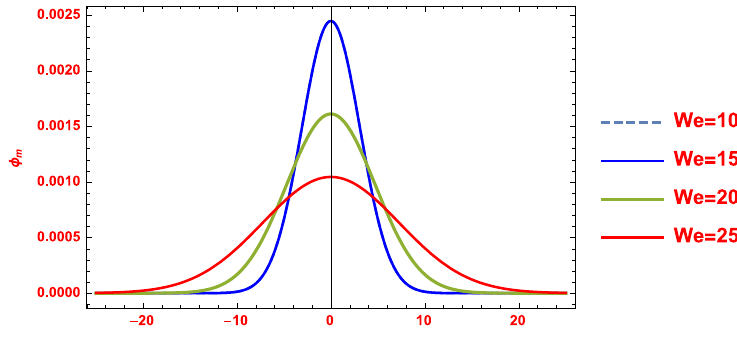
Figure 6. φ m varying along ξ for different M .